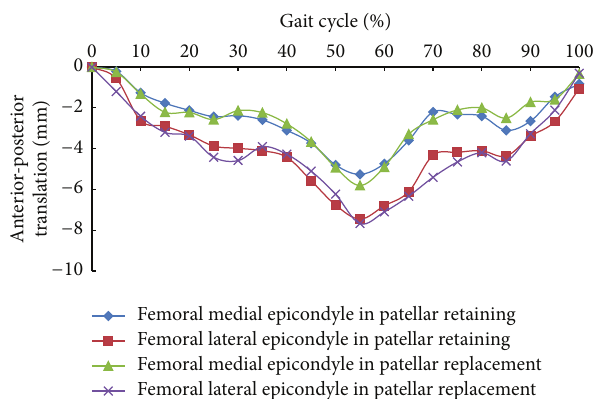
Figure 3: Anterior-posterior translation of femoral lateral and medial epicondyles during the gait cycle.